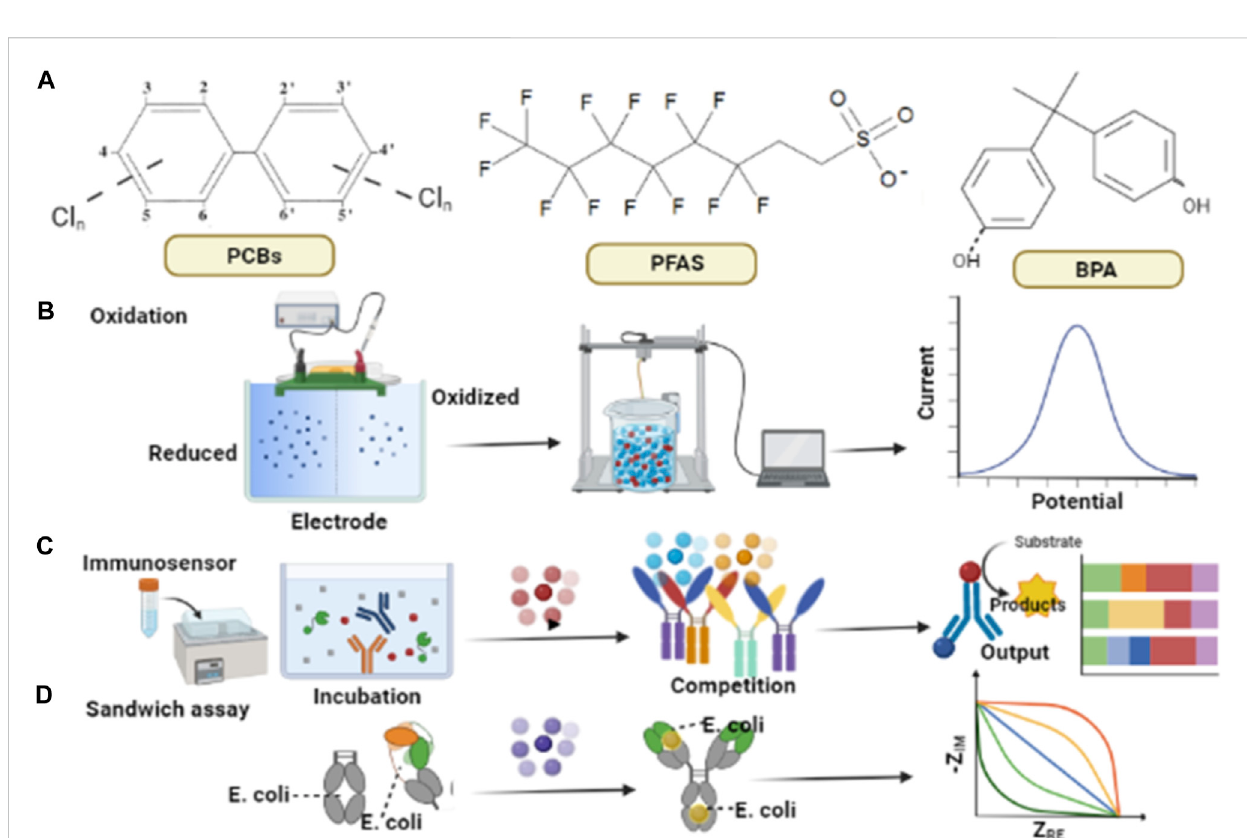
FIGURE 1 Schematicdiagramrepresenting well-developedelectrochemicalapproachesforEDCsmonitoring (A) CommonEDCswithchemicalstructures (B) BPA can be detected by the electro-chemical oxidation methods to fi nd out the presence of its phenolic groups, (C) Competition-based immunoassay assay for PCB sensing, enzymes connect with circular dots of different colors which is pre link to the surface, as a result of this connection the electrochemical signals are being generated depending upon PCB amounts in the solution, (D) An electrochemical sandwich assay, functioning on the binding of E-coli to an electrode is being sketched to monitor